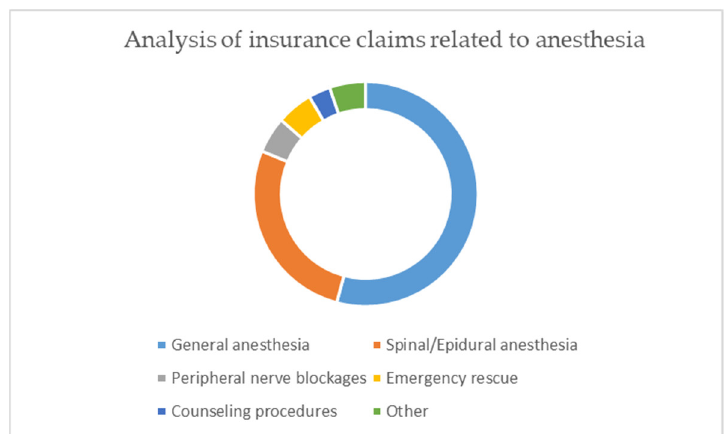
Figure 3. Analysis of insurance claims related to anesthesia.